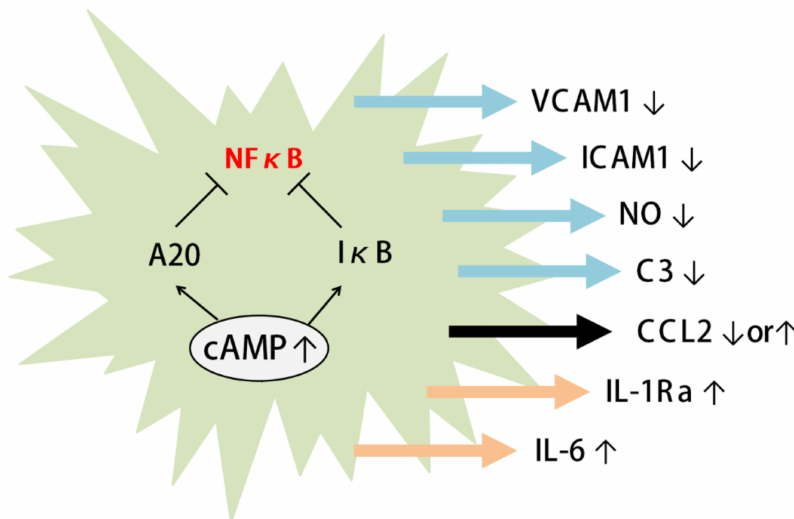
Figure 3. cAMP regulates immune response of astrocytes. The increase in astrocytic cAMP induces A20 and I κ B, both of which suppress the activation of NF- κ B. cAMP increase can reduce the expression of vascular cell adhesion molecule 1 (VCAM-1), ICAM-1, NO, and C3. cAMP increase has also been shown to either increase of decrease the expression of chemokine (C-C motif) ligand 2 (CCL2). In combination with TNF α , astrocytic cAMP increase can result in the increased expression of IL-1Ra and IL-6. Arrows indicate activating pathways. T-bars indicate inhibiting